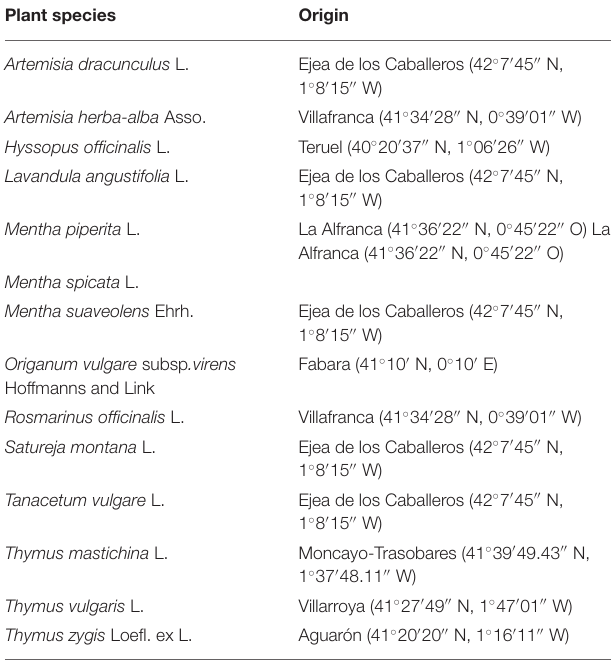
TABLE 1 | List of the plant species used and their origin (experimental field locations in Aragón, Spain, and UTM coordinates). Plant